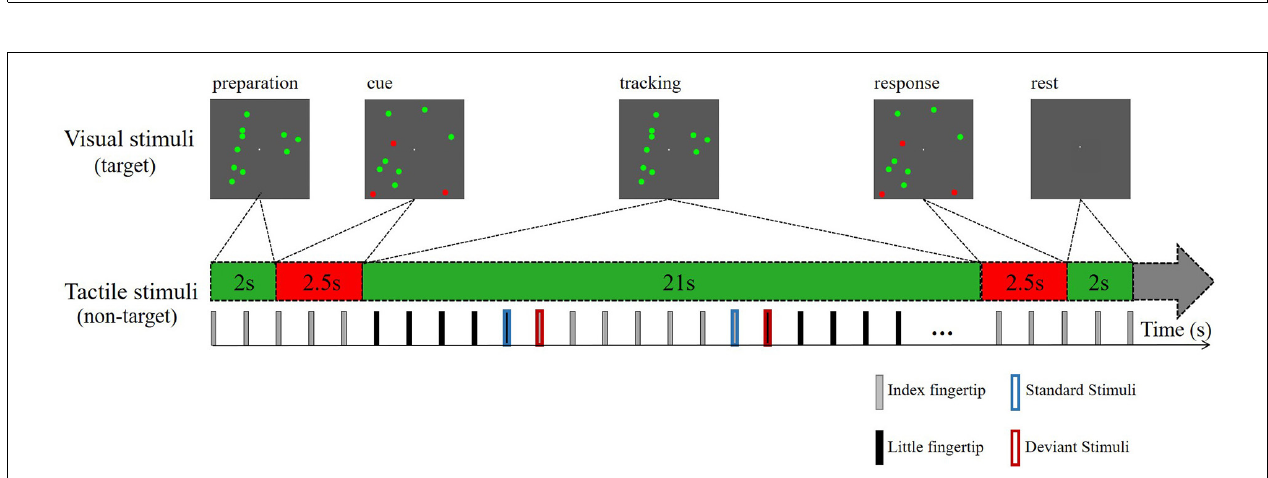
FIGURE 2 | Schematic depiction of the attentive tracking task. Experiment 2 consisted of tracking three different numbers of balls during a task session lasting for 30 s. The task session was repeated twice. The participants were instructed to maintain sustained attention on the tracking tasks, ignoring the tactile